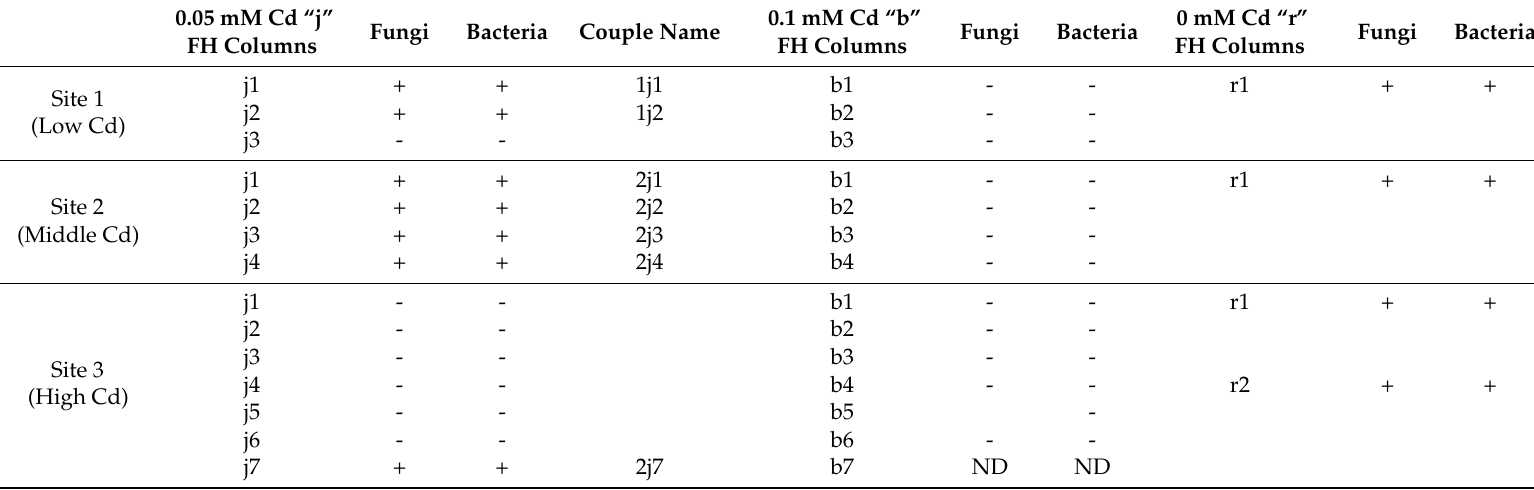
Table 1. Summary of the sampling of bacterial-fungal couples using fungal highway (FH) columns at three different sites in Cd-contaminated soils in la “Vue-des-Alpes”. Cd concentration [mg Cd/kg soil] at each site was: 5.3 at site 1, 6.1 at site 2, and 7.3 at aite 3. “j” FH columns contained 0.05 mM Cd in the target medium, “b” FH columns contained 0.1 mM Cd and “r” FH columns contained no Cd (control FH columns). + stand for growth of a given microbe (either fungi or bacteria) in the target medium and − stand for no